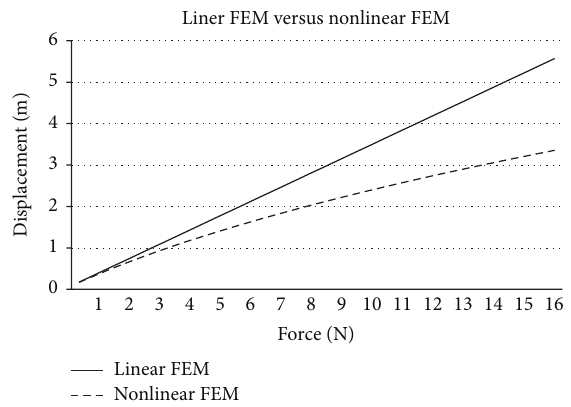
Figure 4: Force displacements (in m) at node 4 for the linear and nonlinear FEMs.